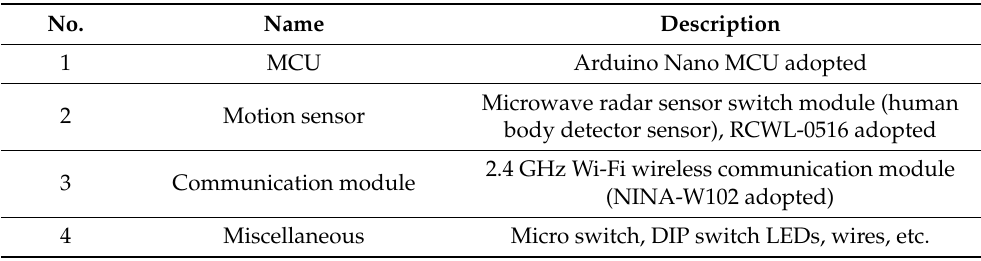
Table 5. The adopted electronic components and their specifications for the proposed IoT-based intelligent LED light.